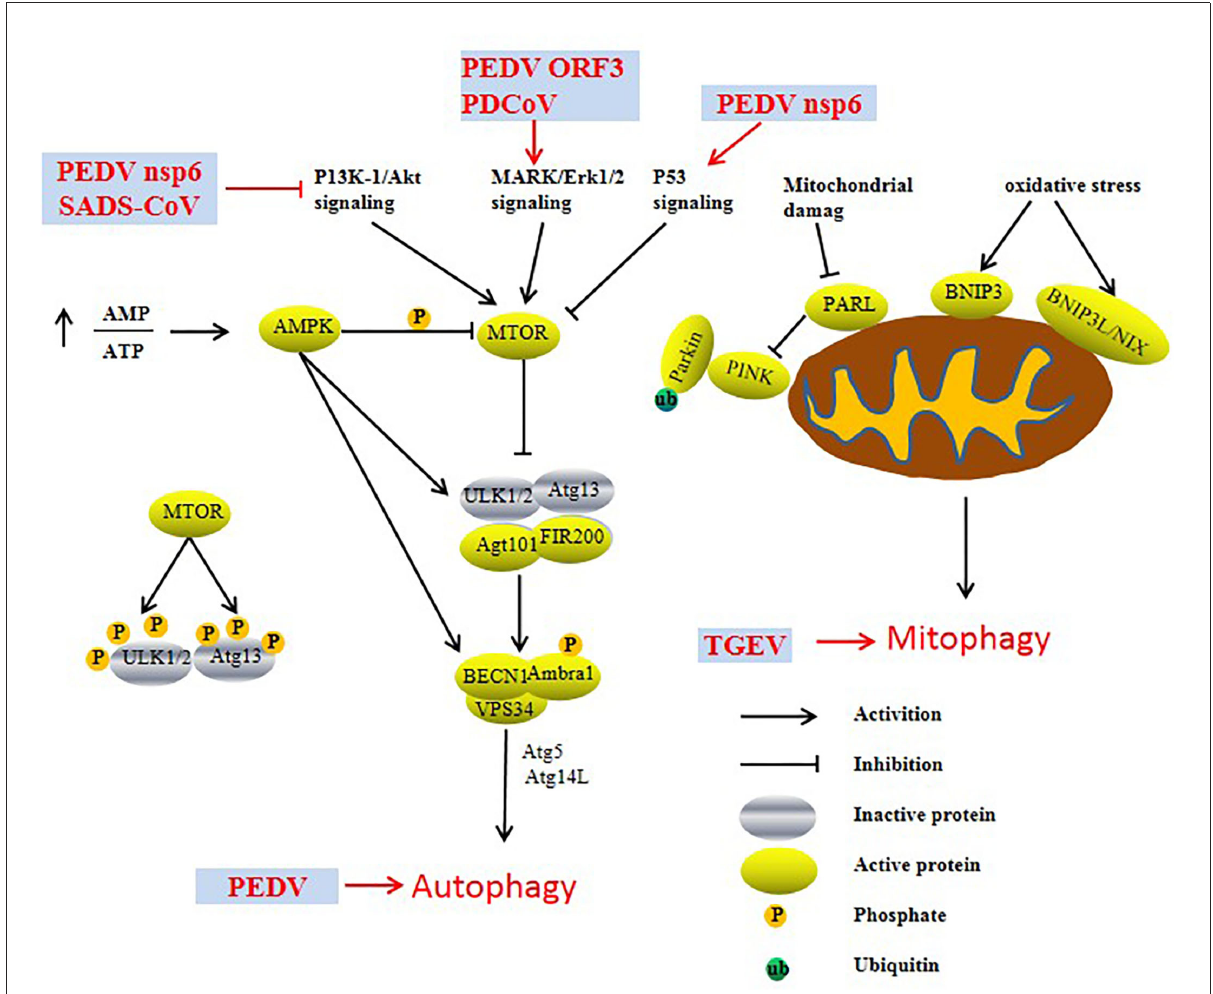
FIGURE2 Induction and modulation of host autophagy by SeCoV